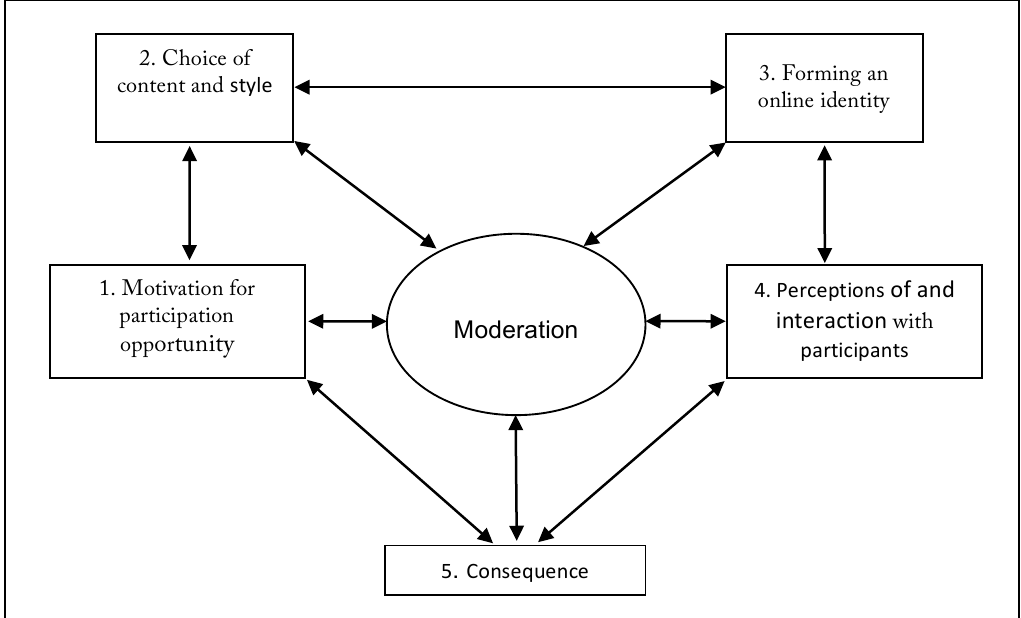
Figure 1 Categories to which moderation